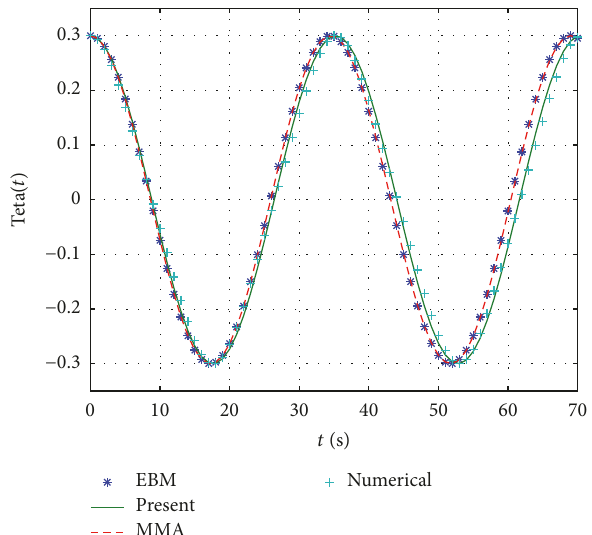
Figure 6: A comparison between the approximate and numerical solutions with Λ = 1 and 𝐴 = 0.3 , Example 2.